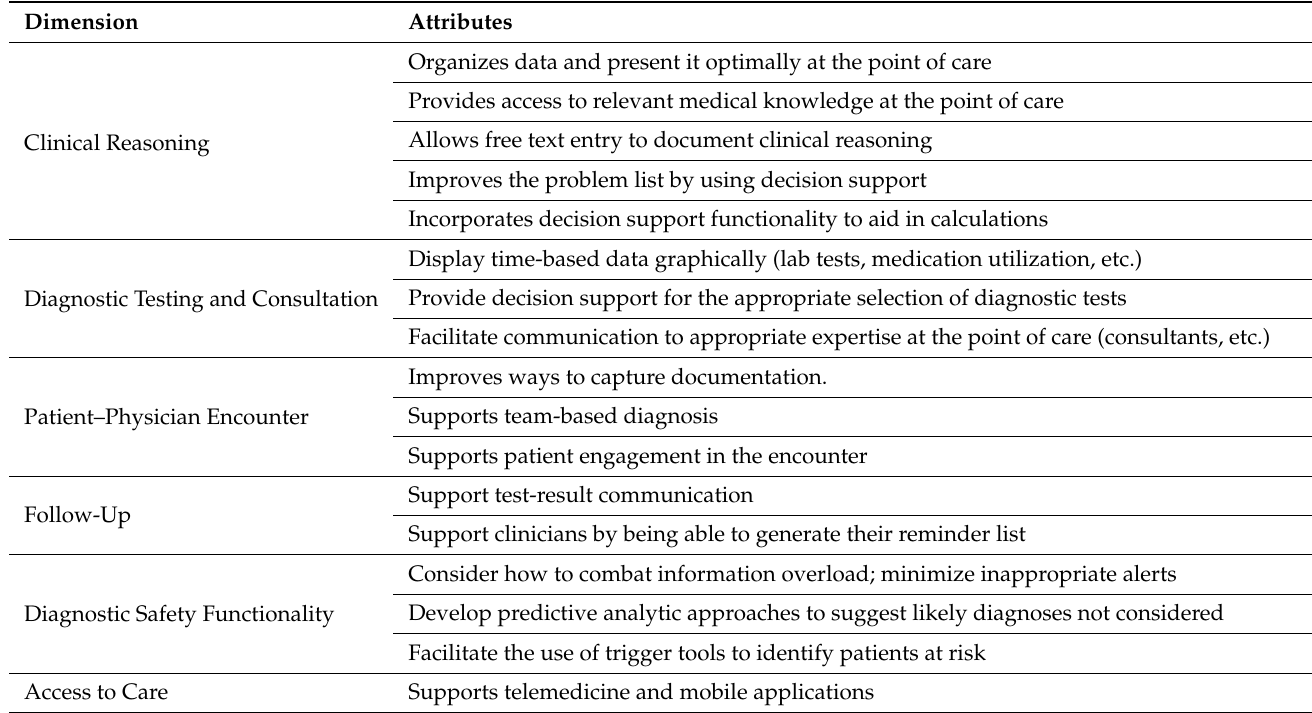
Table 5. The most agreed-on attributes within each